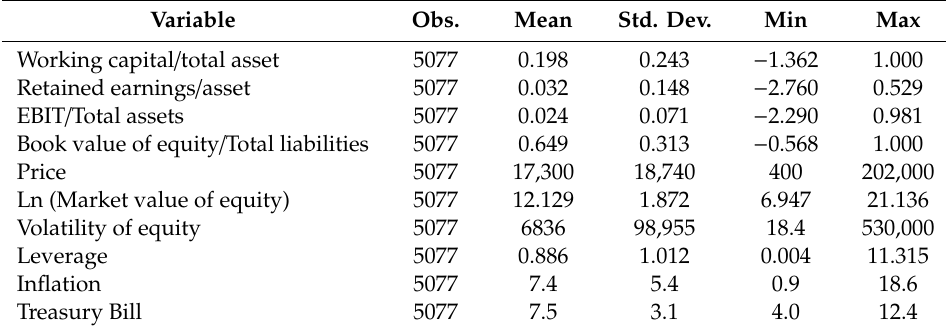
Table 4. Summary statistics for explanatory variables post-GFC